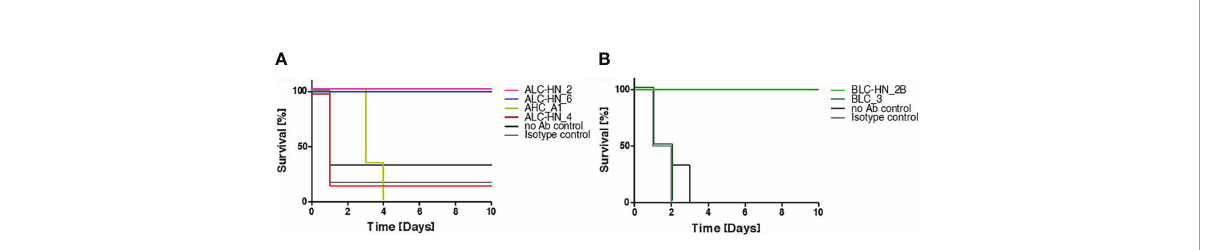
FIGURE 5 Protection of mice against BoNT intoxication by the Centaur mAbs. Mice (n = 6) were intraperitoneally-injected with 5xLD 50 of BoNT/A (A) or BoNT/B (B) pre-incubated with 50 m g of each indicated Centaur mAb. Control groups included “ no Ab control ” and “ non-speci fi c isotype control ” (anti-ricin mAb). Mice survival was monitored for 10 days